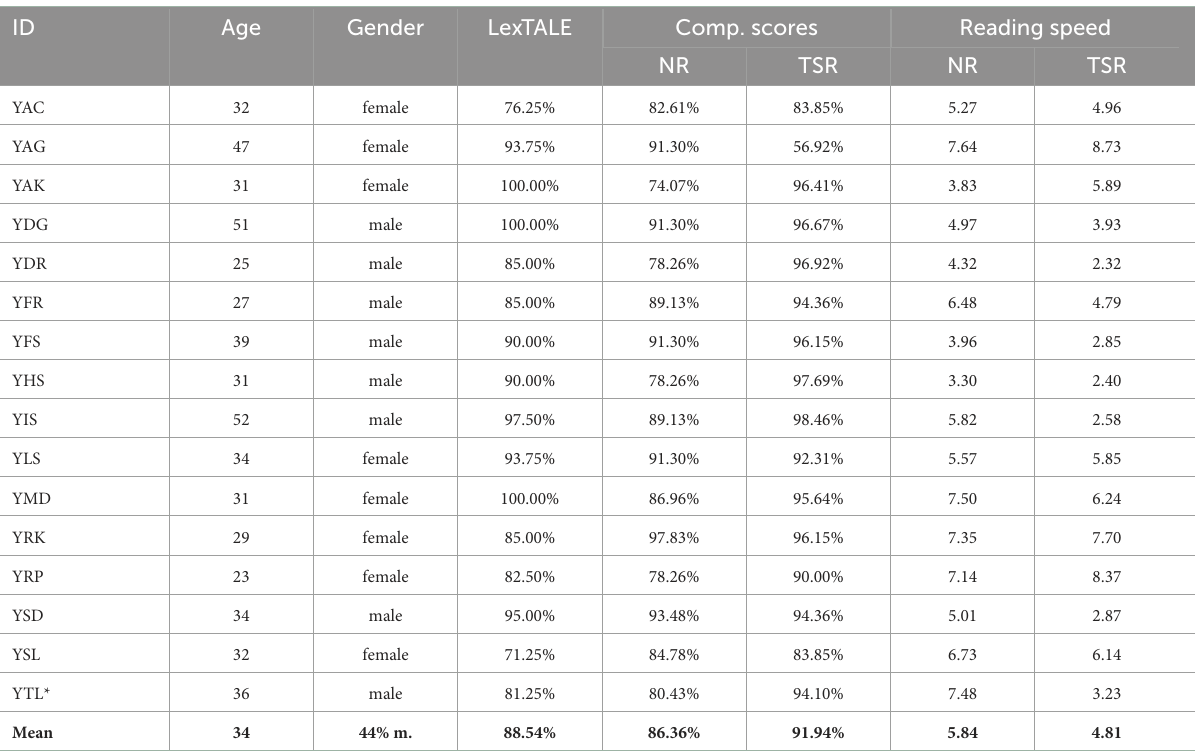
TABLE 3 Subject demographics for ZuCo 2.0, LexTALE scores, scores of the comprehension questions, and individual reading speed (i.e., seconds per sentence) for each task. ID Age Gender LexTALE Comp.